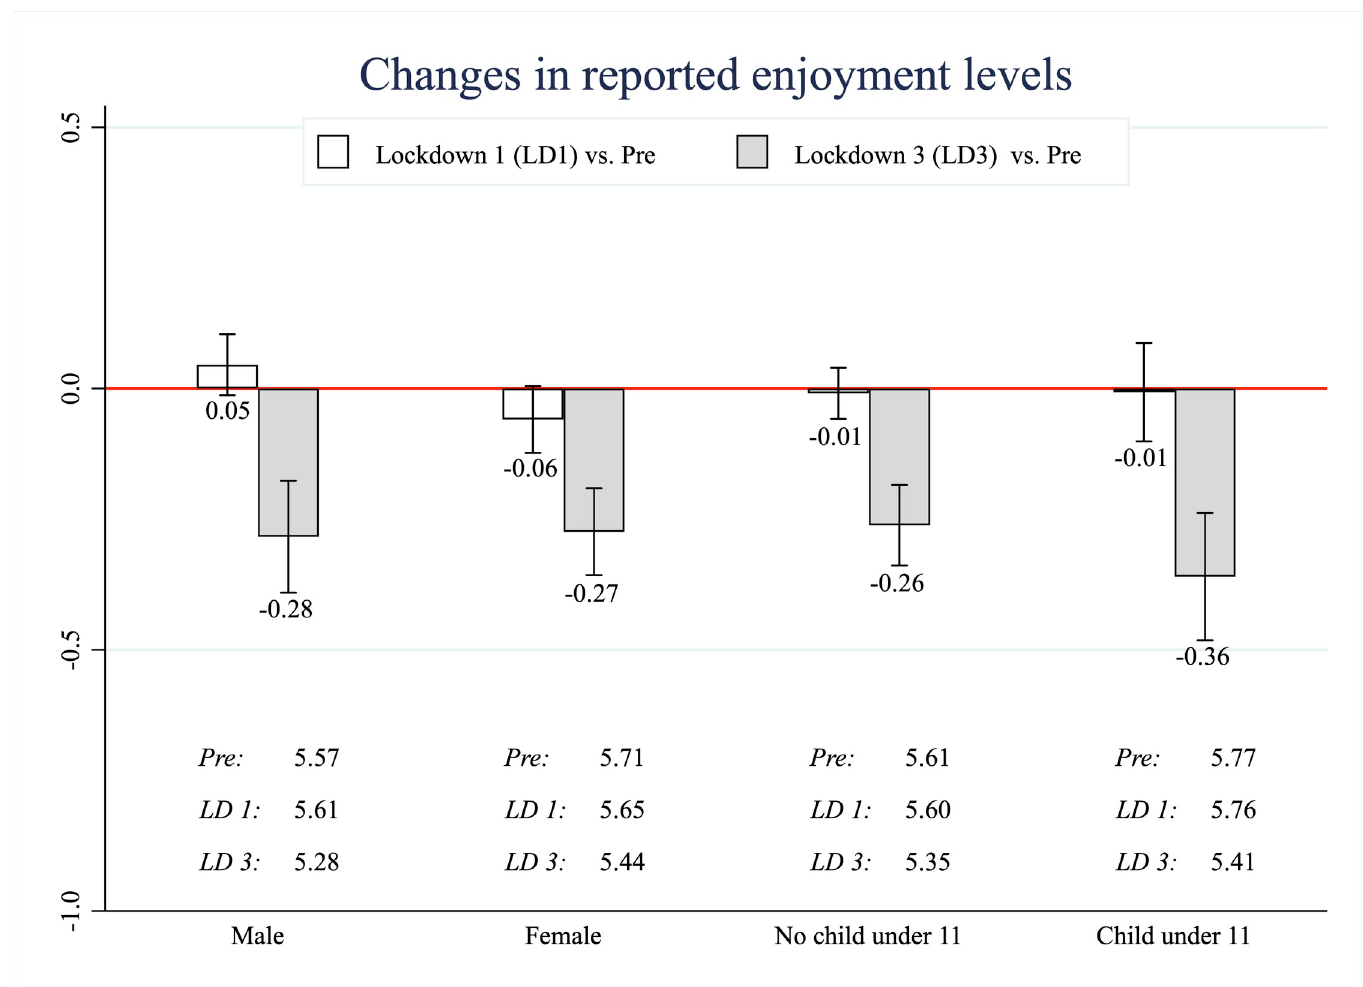
Fig 4. Changes in self-reported enjoyment. Bars present average within-person changes in self-reported enjoyment between the pre-pandemic timepoint (February 2020) and the first lockdown (May 2020) or the third lockdown (March 2021). Error bars represent 95% confidence intervals, and average levels for each subgroup are reported underneath the bars. 1 standard deviation corresponds to 0.76 units on the 1–7 enjoyment Likert scale in the pre-pandemic period. Note that the conditional means were calculated separately (either by gender or household composition), so the four subgroups shown are not mutually